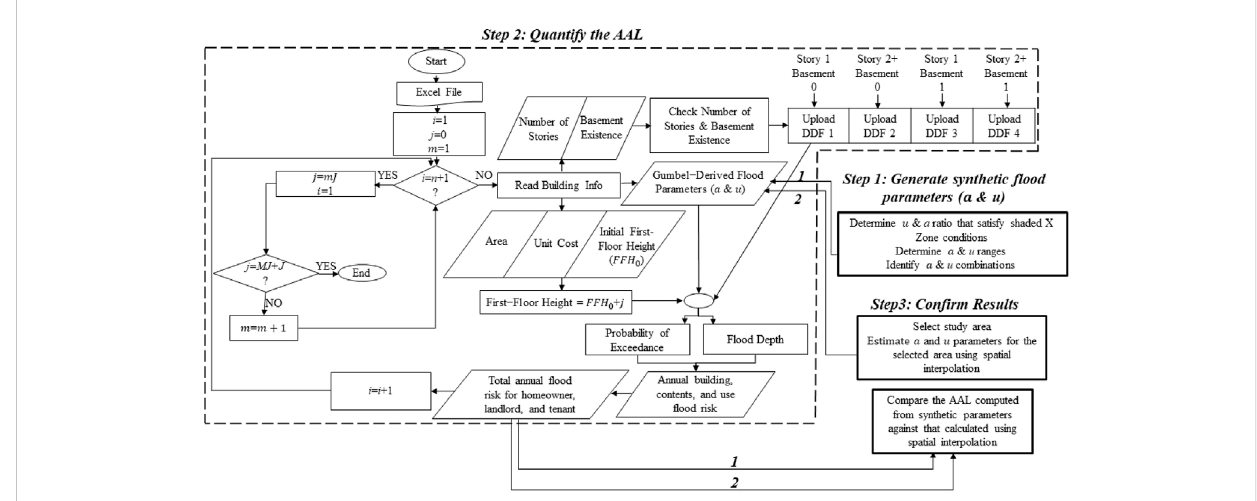
FIGURE 1 Computational framework to quantify and con fi rm AAL in the shaded X Zone.